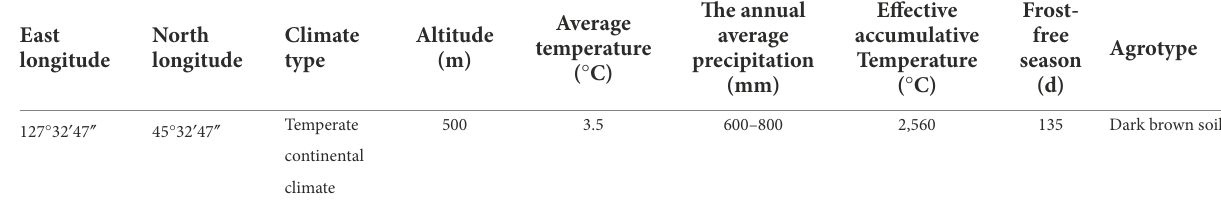
TABLE 1 Main geographical and climatic condition of Daquanzi Farm Station.